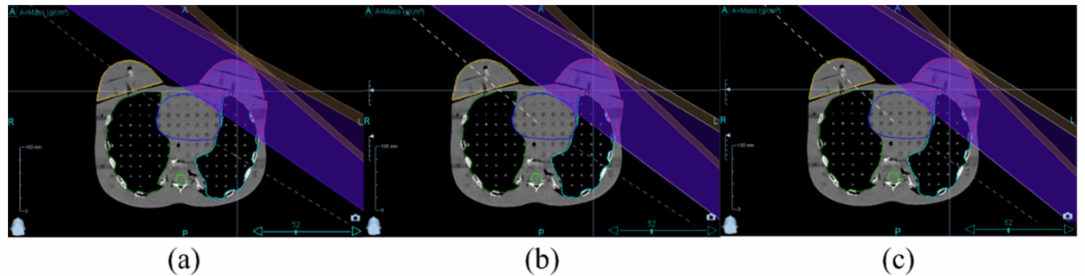
Figure 2. Example of TD plans in two directions with RAO {( a ) 308 ◦ ( b ) 310 ◦ ( c ) 312 ◦ )} and LPO